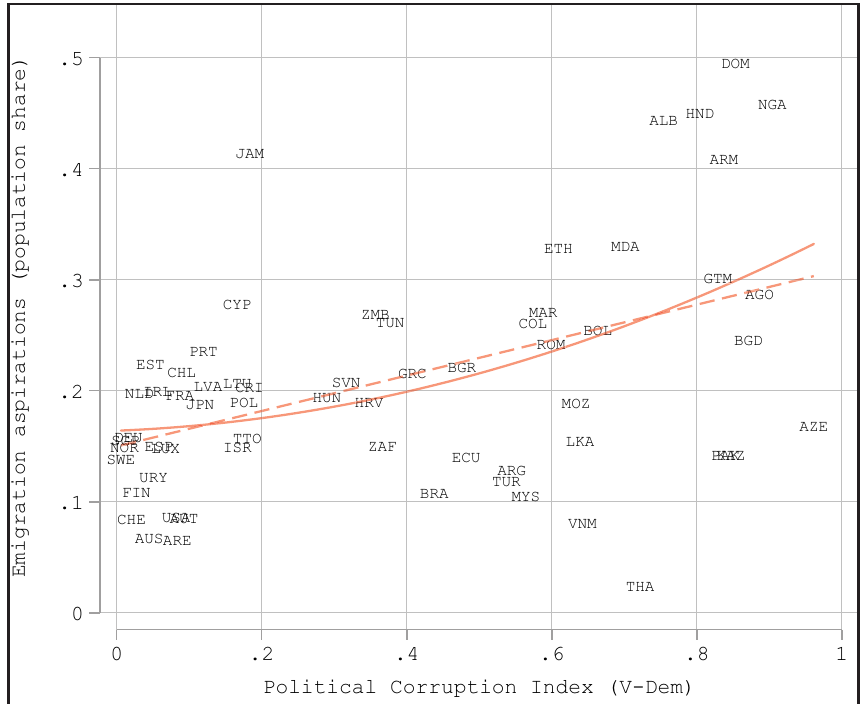
Figure 1 Relationship of corruption and share of people with migration